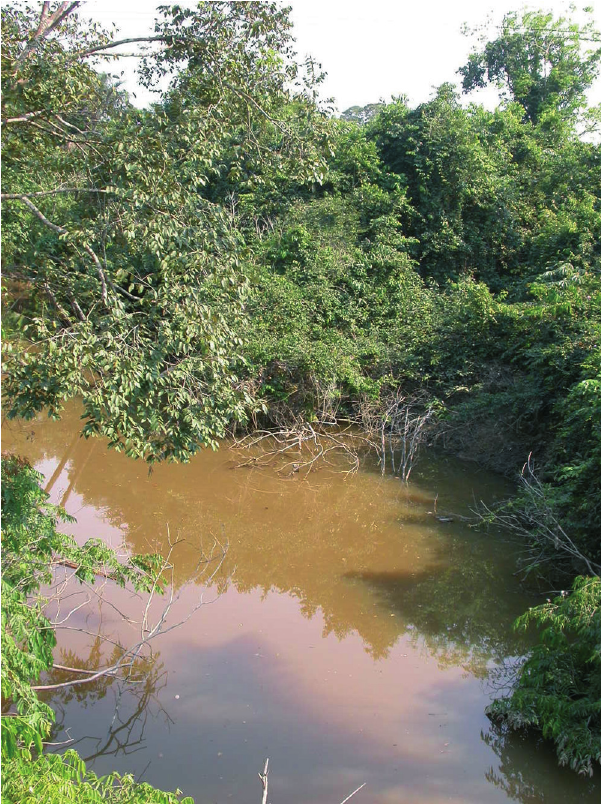
Fig. 9. Type locality of Amazonspinther dalmata . Stream crossing road Transamazônica about 12 km west of